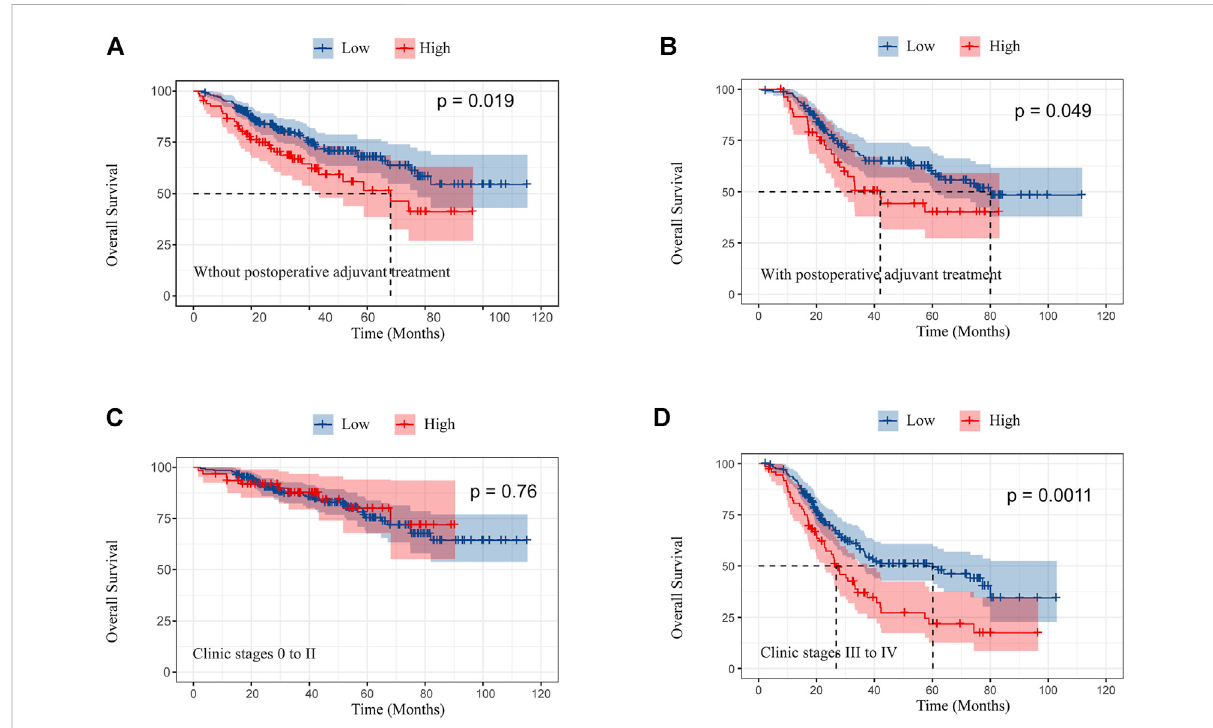
FIGURE 3 Kaplan – Meier curves of overall survival in female patients without postoperative adjuvant treatment (A) and with postoperative adjuvant treatment (B) ; overall survival in clinic stages 0 to II (C) and III and IV (D) according to preoperative TC.